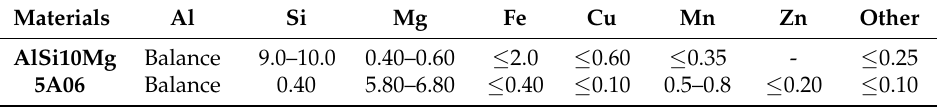
Table 1. Chemical composition of forming material powder and base materials